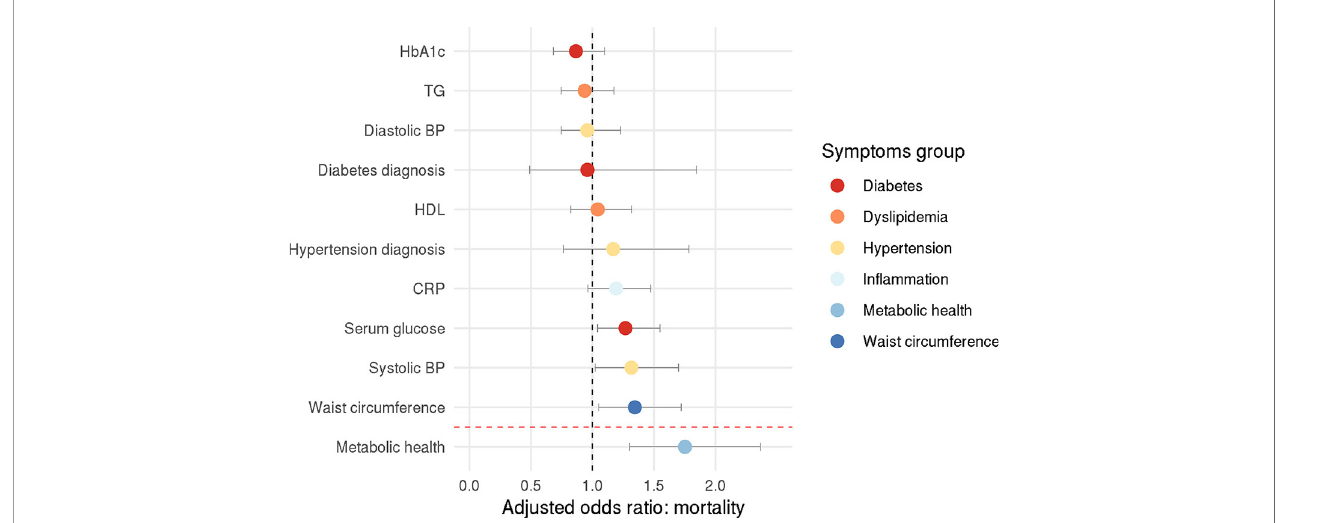
FIGURE 2 | Odds ratio for COVID-19-related death. Circles represent adjusted odds ratios, error bars represent 95% con fi dence